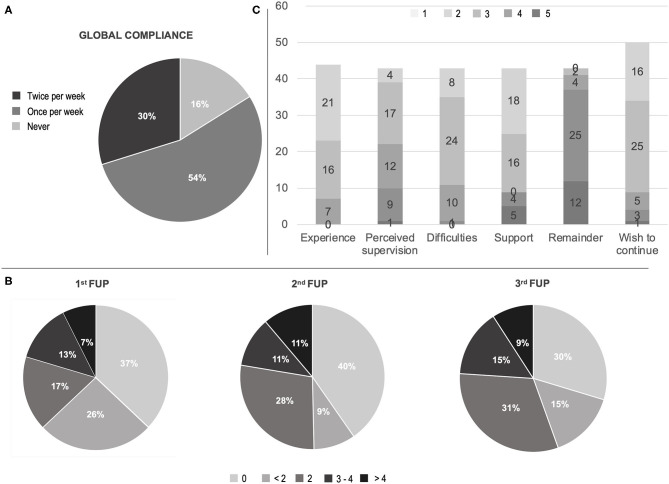
Compliance and satisfaction questionnaire results. (A) Global compliance; (B) First to third week check-point for compliance (times of app utilization for each week); (C) Visual analog scale (VAS) on satisfaction questionnaire experience, perceived medical control, difficulties in using the app, need of support in using the app, burden by app remaining, wish to continue the remote patient monitoring. Scores in C ranged in ascending order from one (light gray) to five (dark gray) according to patient satisfaction. FUP, follow-up call.